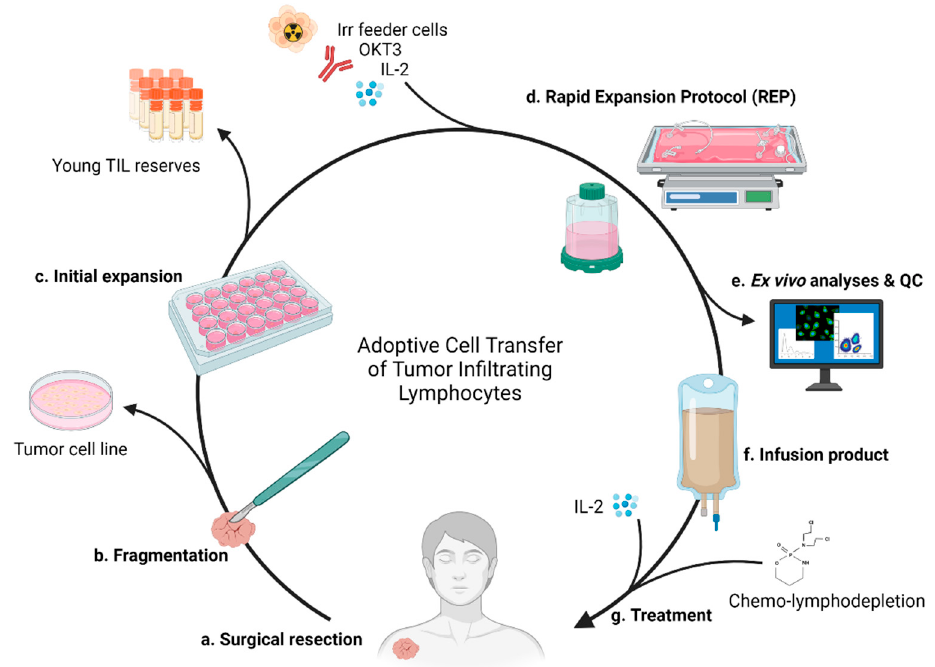
Figure 1. TIL production and administration. ( a ) Full or partial surgical resection of tumor. ( b ) The tumor is minced via scalpel. Tumor material can be saved to establish cell lines for future assays. ( c ) Fragments are placed into individual wells of a 24-well plate with culture medium. Harvested young TILs can be saved for future autologous therapy or experiments, while others ( d ) proceed to REP with irradiated allogenic feeder cells, OKT3, and IL-2 for massive expansion. Use of bioreactor or gas-permeable flasks. ( e ) Quality of the cells are analyzed prior creation of ( f ) the infusion prod- uct. ( g ) Treatment of the patient includes the preparative lymphodepletion, administration of the autologous TIL product, and subsequent IL-2